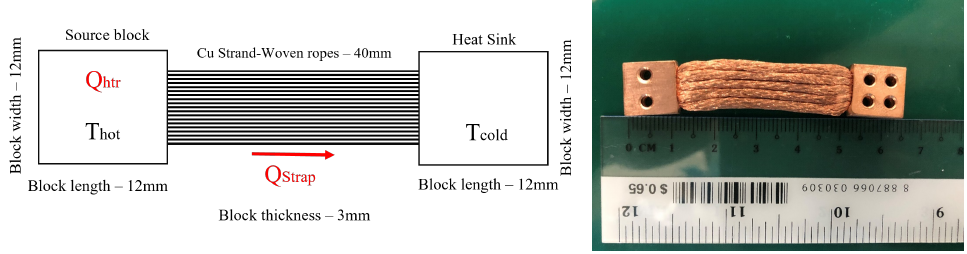
Figure 3. Thermal Strap—test